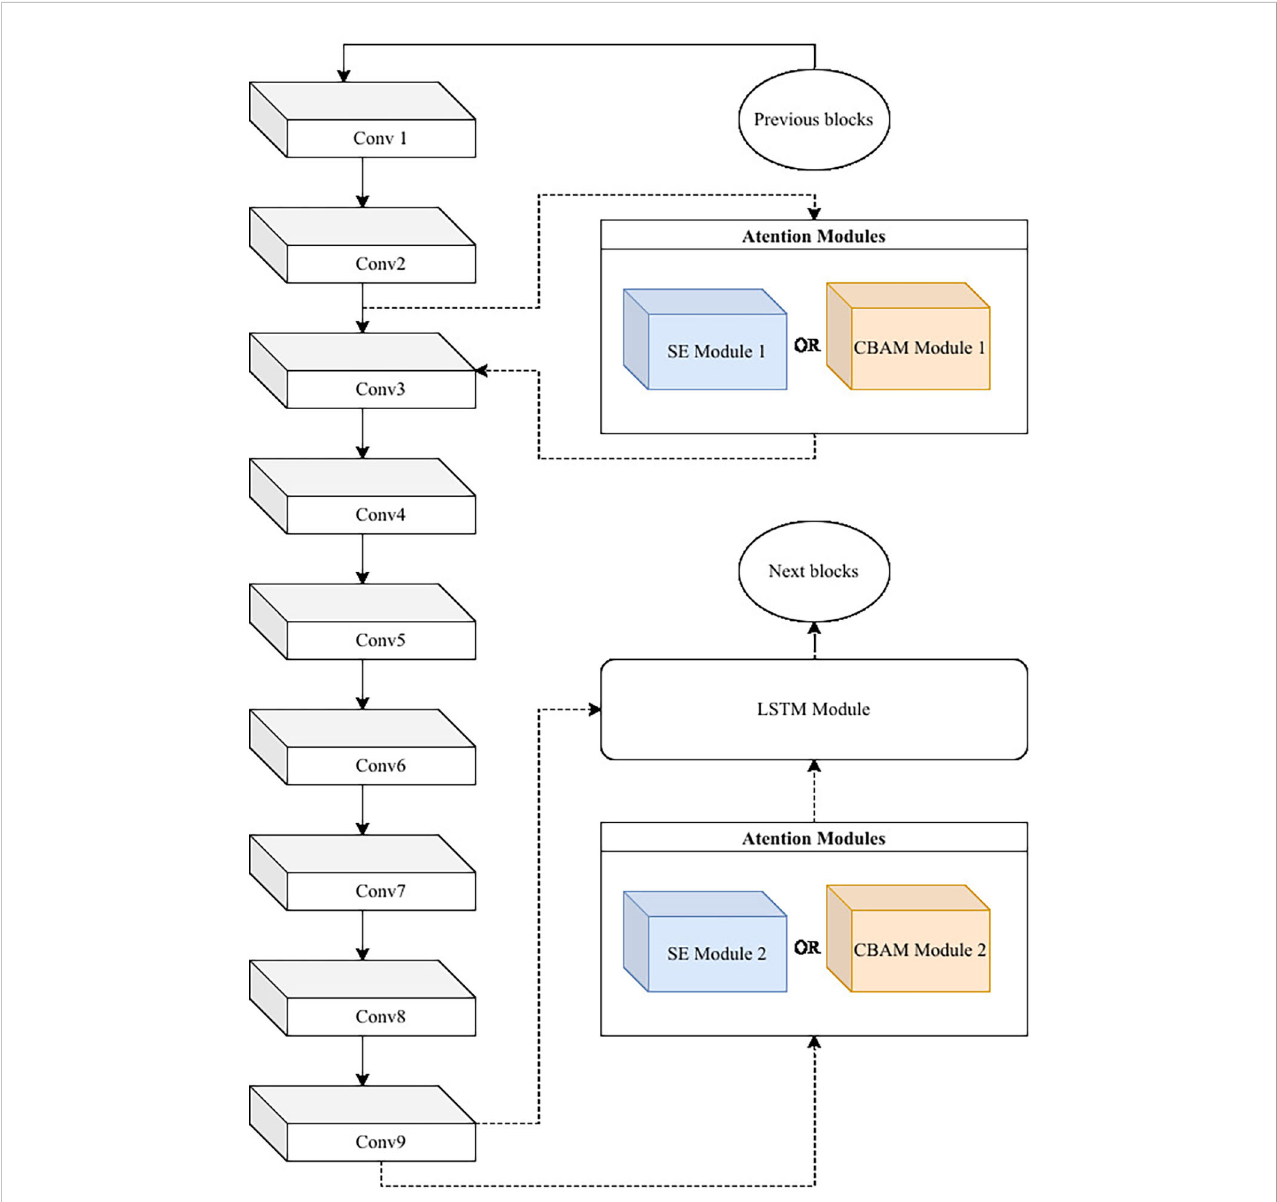
FIGURE 9 The position of each optimization module in the 9-layer convolutional